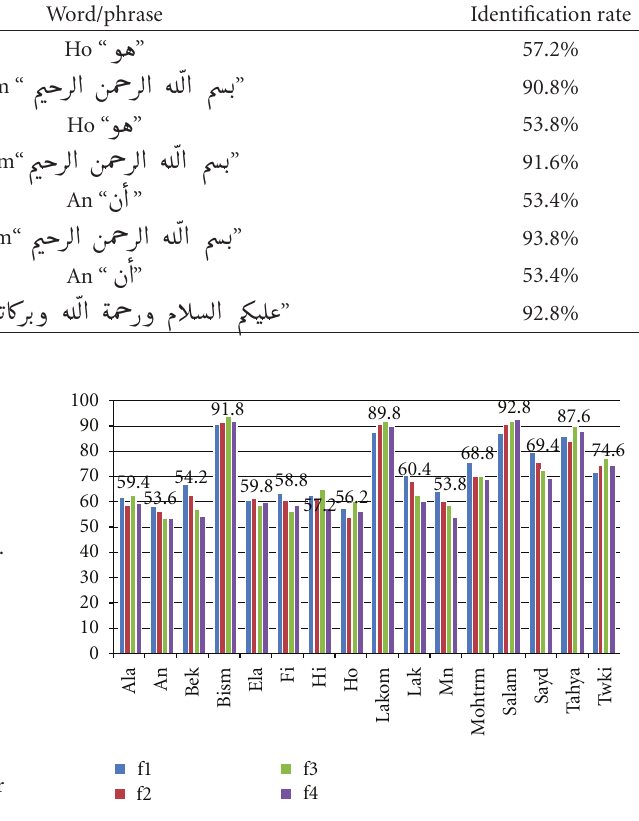
Figure 11: Performance histogram of the edge-based directional features for di ff erent Arabic